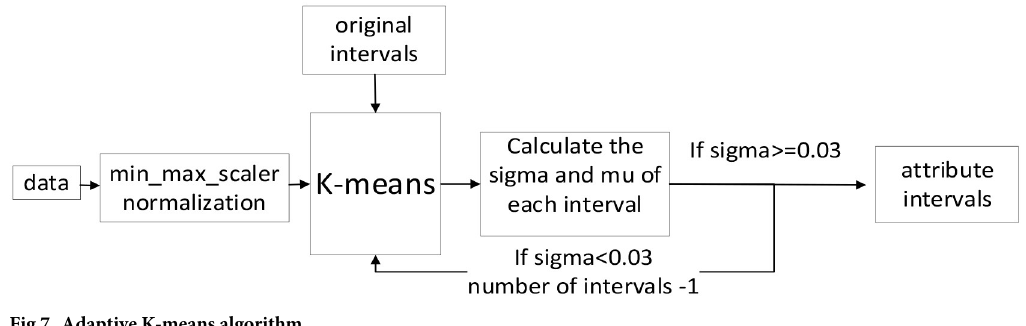
Fig 7. Adaptive K-means